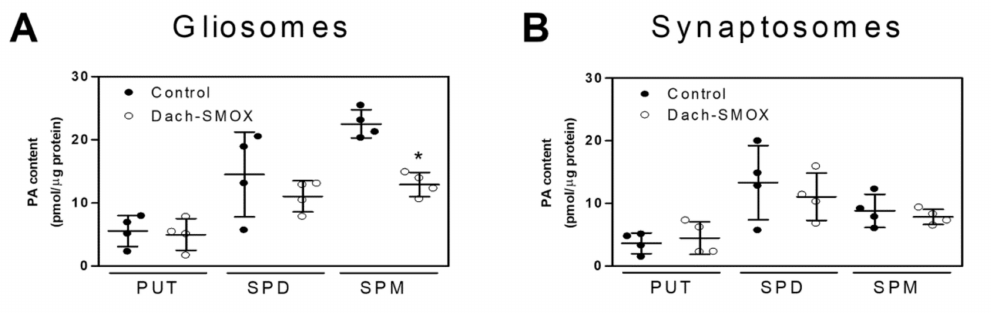
Figure 2. Significant reduction of Spm content in Dach-SMOX cerebrocortical gliosomes. Put, Spd, and Spm content in gliosomes and synaptosomes from Dach-SMOX and control mice. For details, see Materials and Methods. Filled circles represent the PA content (pmol/ µ g protein) in control (black) and Dach-SMOX (white) gliosomes ( A ) and synaptosomes ( B ). Mean and SD are reported ( n = 4). * p < 0.05 according to one-way ANOVA test and post hoc test Tuckey.